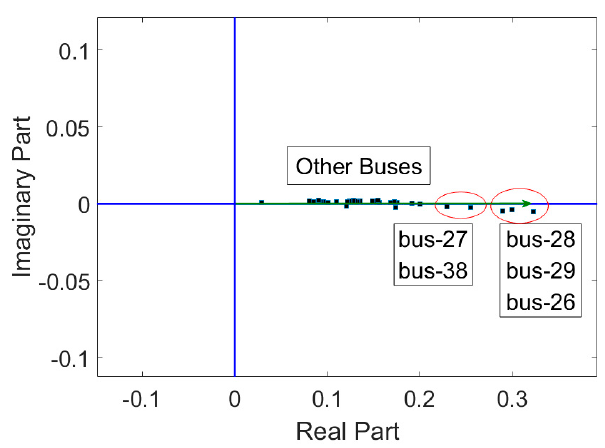
Figure 3. Nodal voltage mode shape of 131.6 Hz mode in the original system.